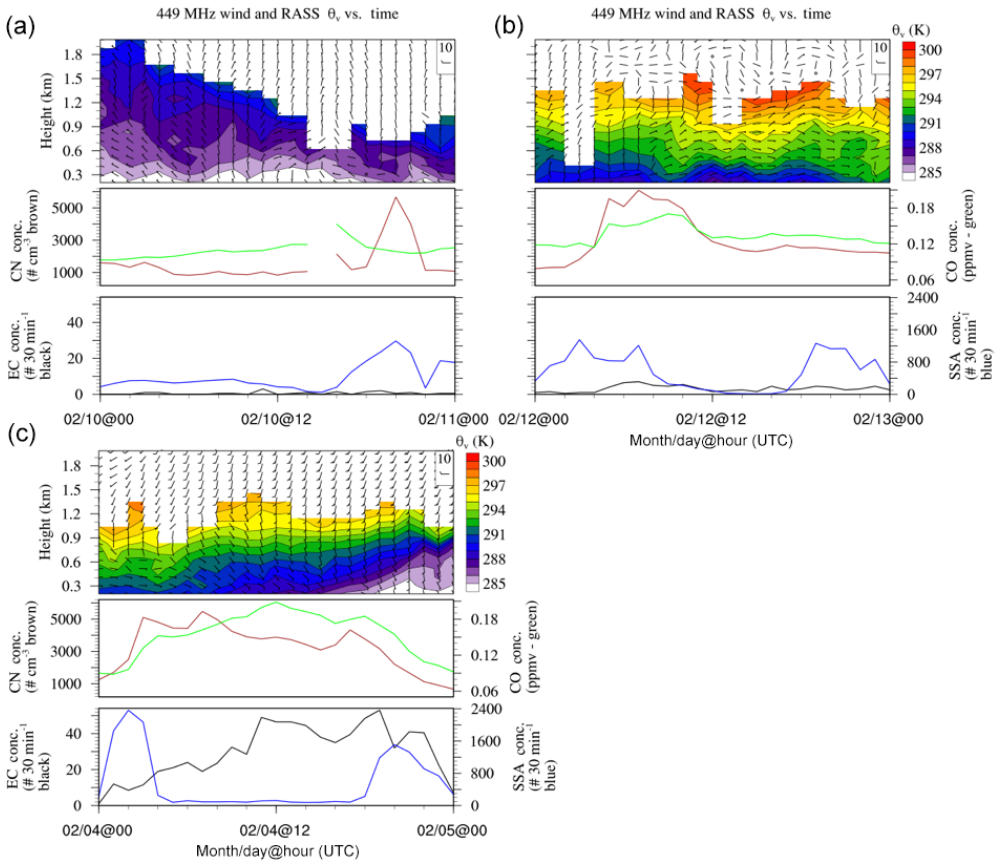
Figure 2. (a) Horizontal wind barb and θ v every 100m from 300 to 1900ma.g.l. from NOAA/ESRL 449MHz wind profiling radar and RASS at BBY (top), hourly CO concentration (ppmv – green) and CN (no.cm − 3 – brown) (middle), number particles classified as EC or aged EC (black) and SS or aged SS (blue) per 30min interval from ATOFMS (bottom) during a 24h period (10 February 2015) classified as CTL. (b) As in (a) but for a 24h period (12 February 2015) classified as LOCAL. (c) As in (a) but for the 24h surrounding PGF 4.